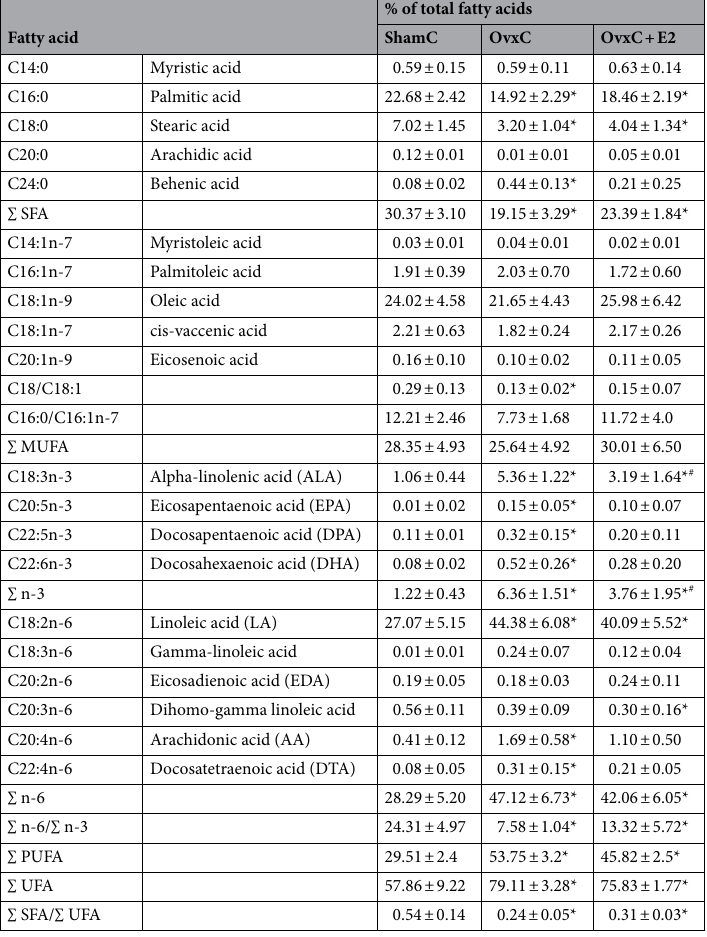
Table 2. Fatty acid composition of RET cholesteryl ester lipids obtained from ovariectomized (Ovx) or Sham operated rats, fed a control (C) diet, subjected or not to oestrogen replacement therapy (E2). Data presented as means ± standard error (SE) of the % of total FAs. n = 6 for each group. SFA saturated fatty acids, MUFA monounsaturated fatty acids, PUFA polyunsaturated fatty acids. *p < 0.05 vs ShamC; #p < 0.05 OvxC vs OvxC +